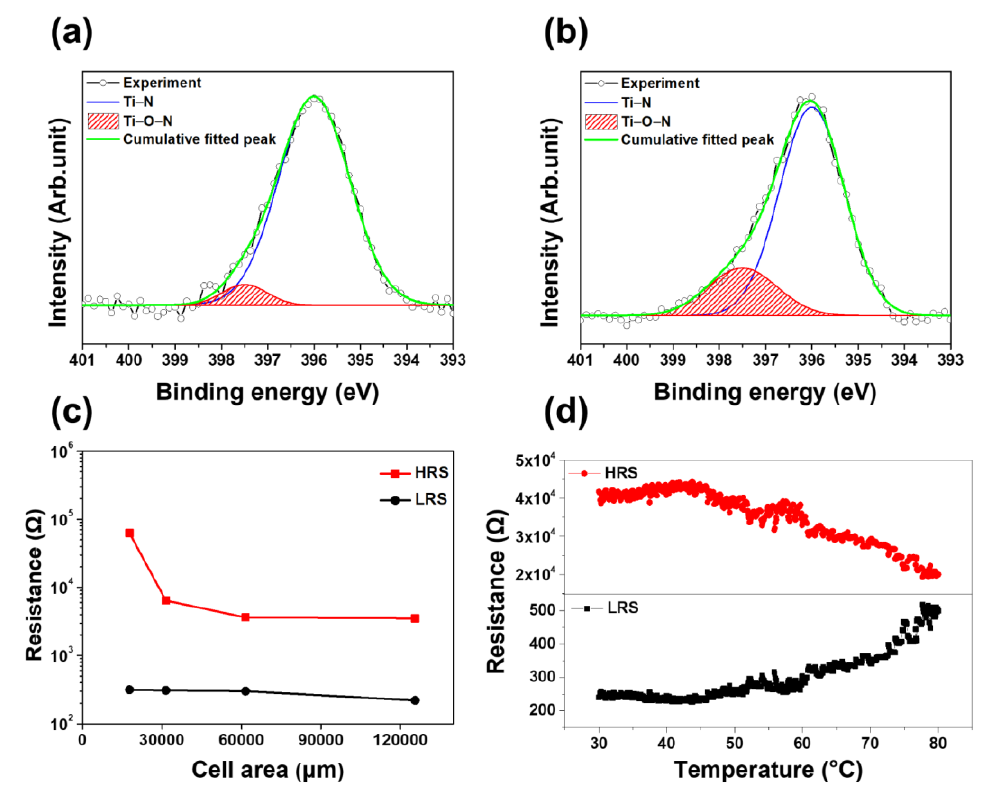
Figure 2. XPS N1s spectra of the PCMO film in the ( a ) HRS and ( b ) LRS. ( c ) Variation in the R HRS and R LRS values with respect to the size of the top electrode and ( d ) change in the R HRS and R LRS values with respect to the temperature. The PCMO film was grown at 100 mTorr OP.